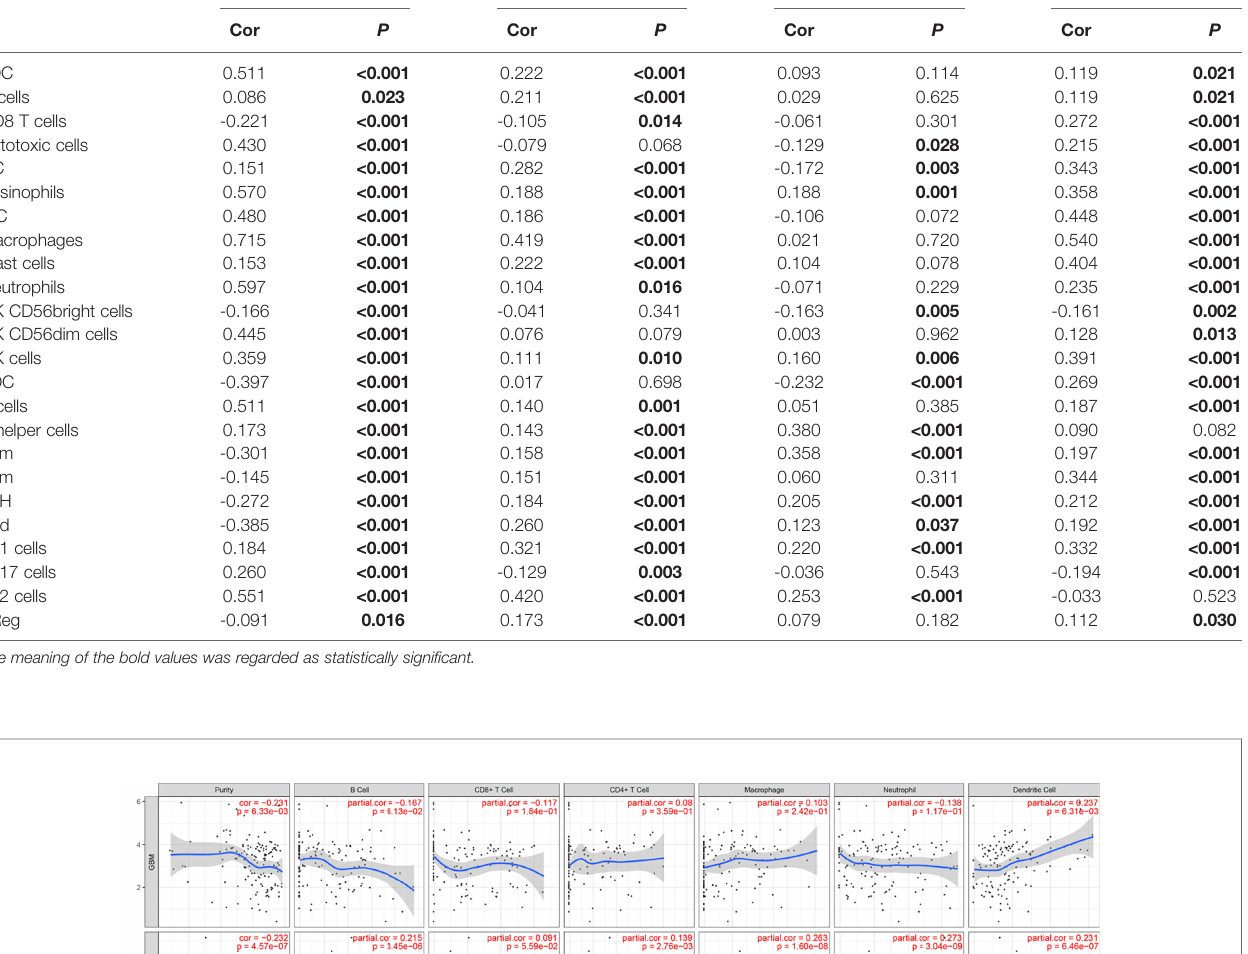
TABLE 3 | Correlation analysis between GPX8 and immune cells. Cells